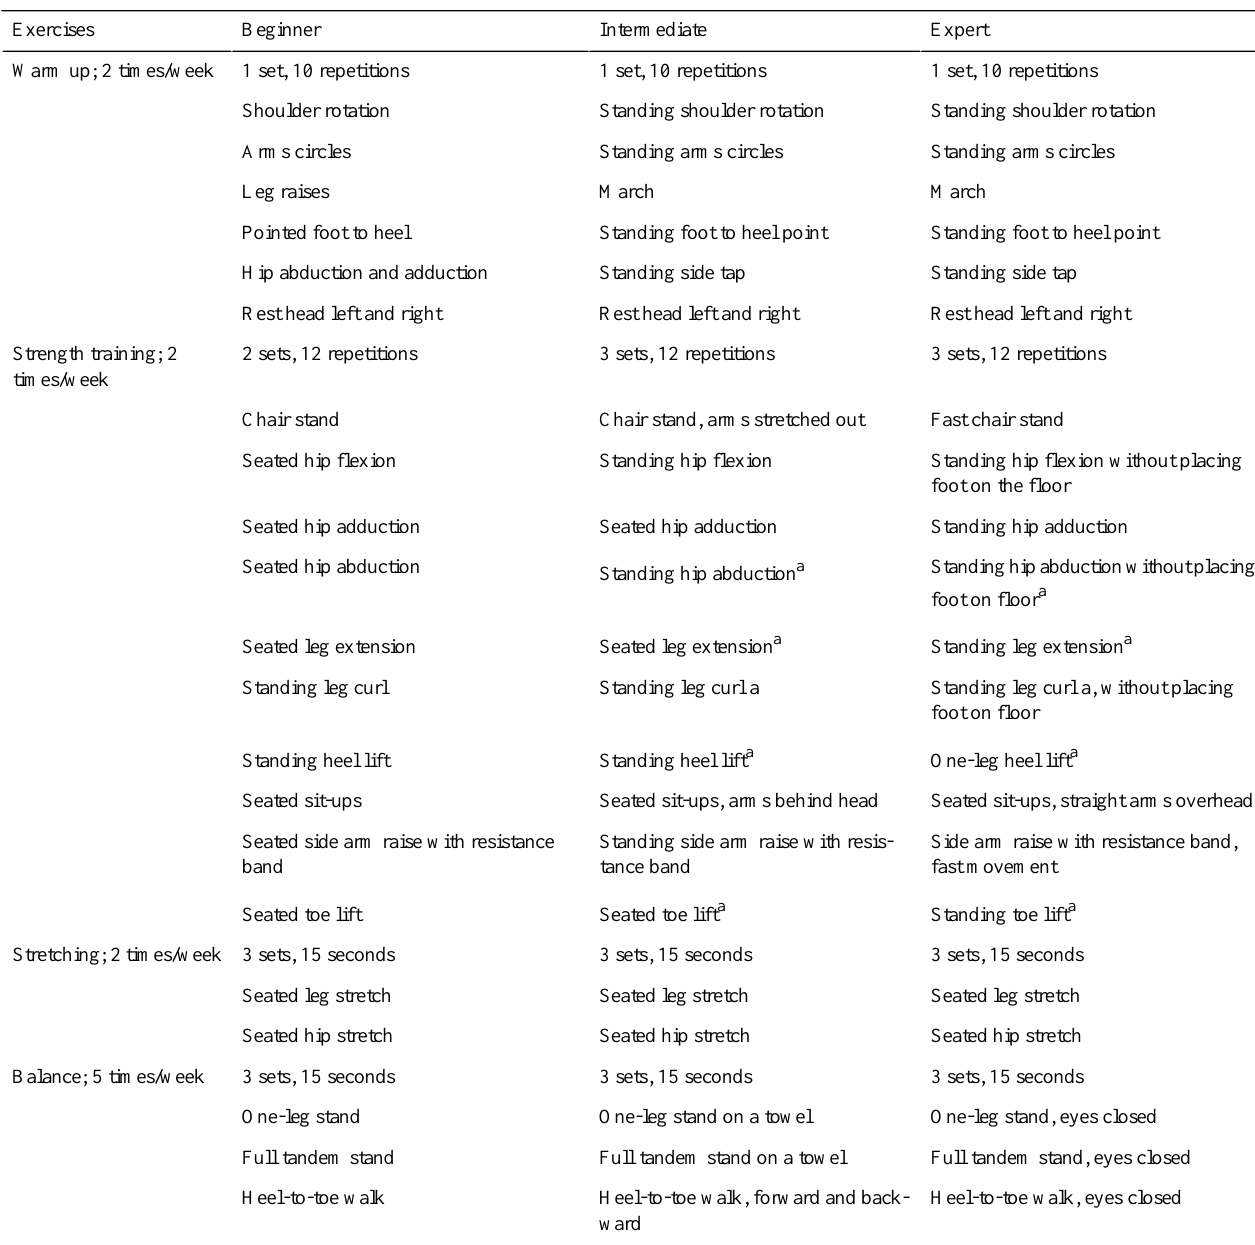
Table 1. Exercises of the intervention program. ExpertIntermediateBeginnerExercises